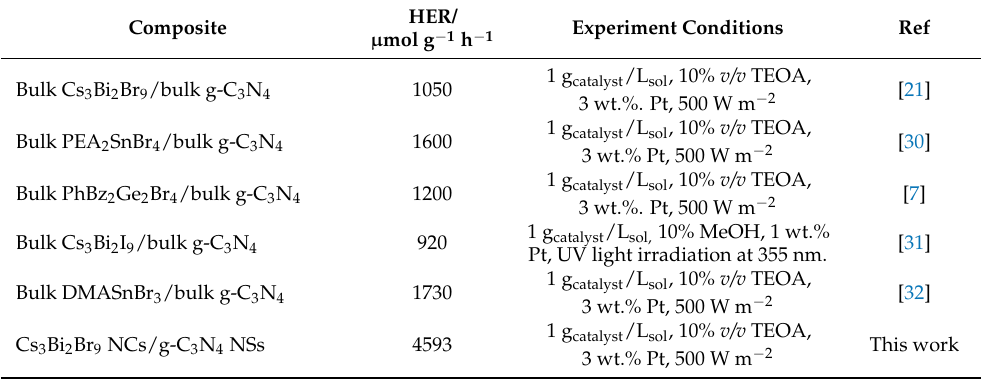
Table 1. HER values reported in the literature using lead-free perovskites/g-C 3 N 4 composites. Composite